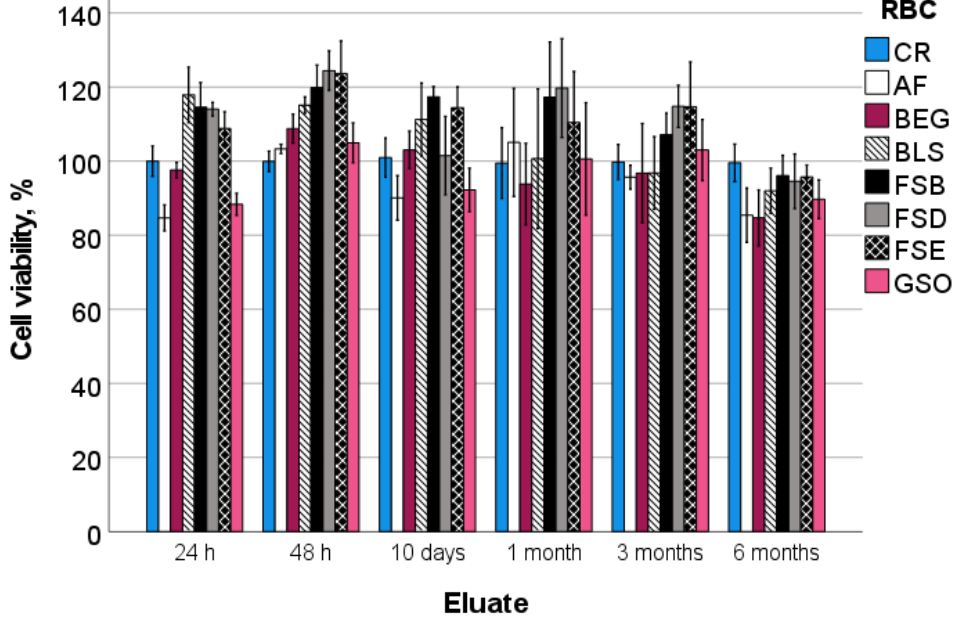
Figure 1. Cell viability (mean and standard deviation) in percentage of the negative control (CR), ordered by chronological elution times. Material abbreviation: AF = Admira Fusion; BEG = Brilliant EverGlow; BLS = Beautifil II LS; FSB = Filtek Supreme XTE Body; FSD = Filtek Supreme XTE Dentin; FSE = Filtek Supreme XTE Enamel; GSO = Grandio SO.